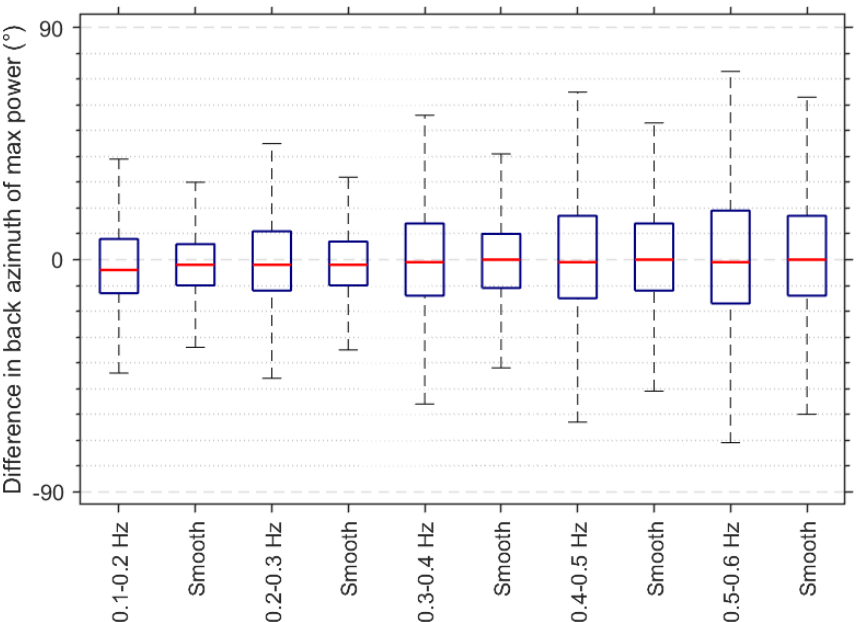
Figure 2. Difference in the direction of the maximum power between (i) model and vespagram (indicated with a frequency band name on the x axis) and (ii) smoothed model and vespagram (denoted as “smooth” on the x axis) over 6 years of data. The red lines present the median, blue boxes indicate the 25 to 75 percentile range, and whiskers correspond to ± 3 standard